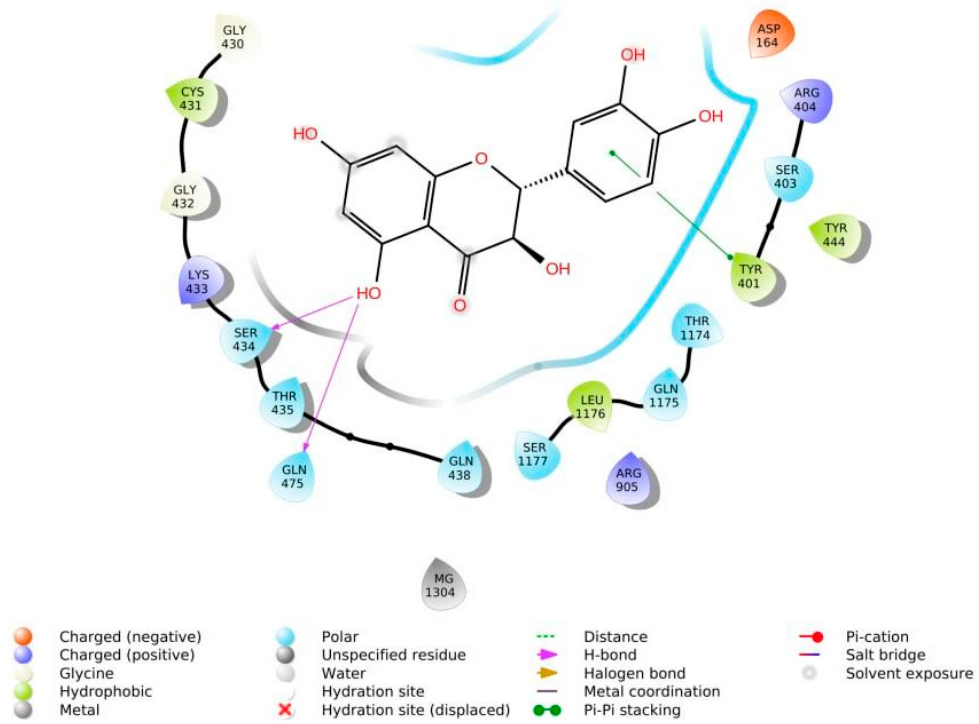
Figure 4. Interaction of taxifolin and P-glycoprotein.